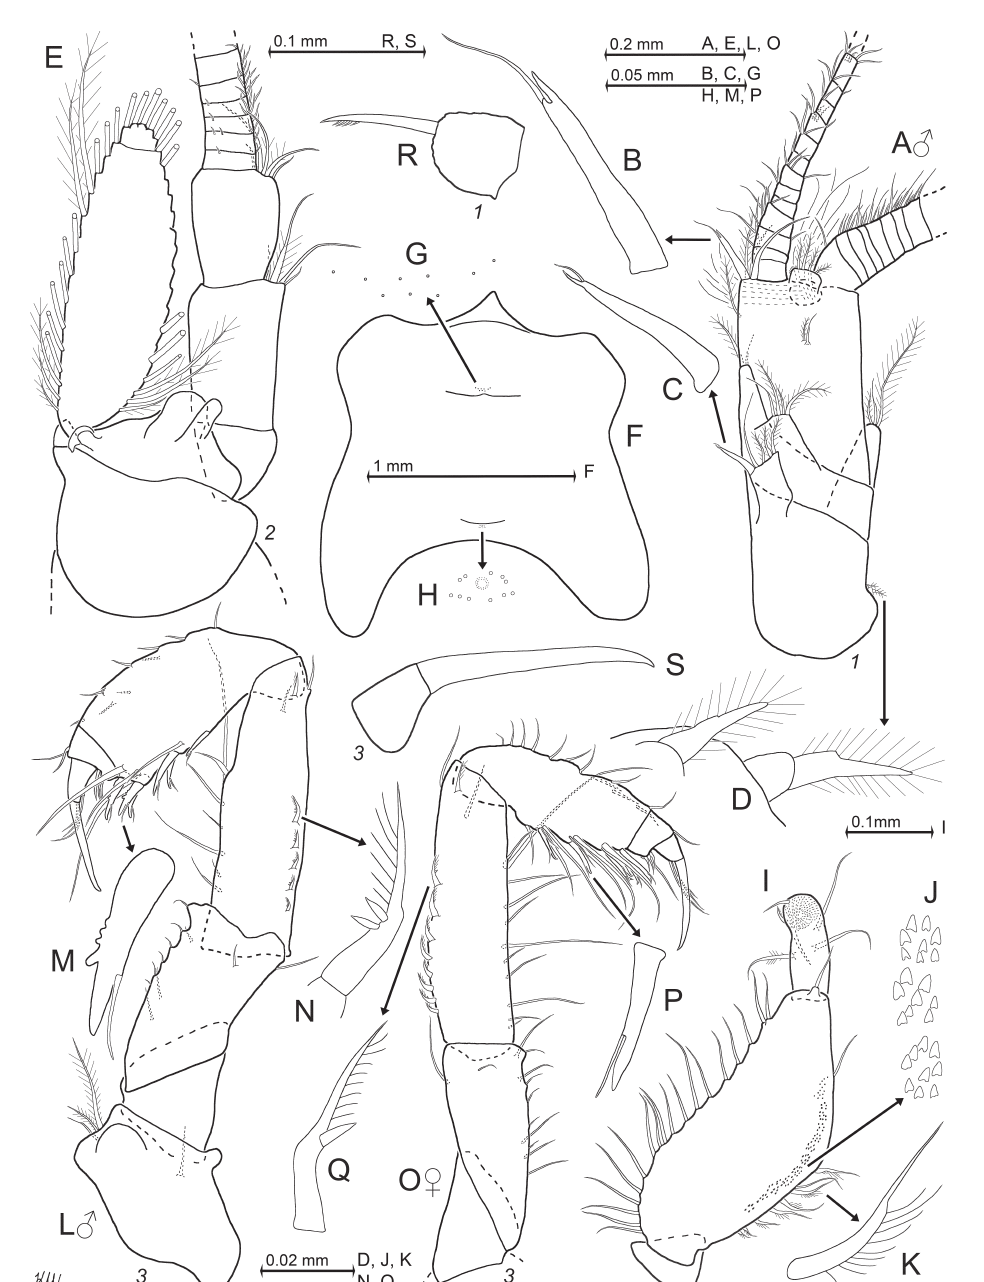
Fig. 2. Heteromysis smithsoniana sp. nov., paratypes, ♂♂ with body length 4.8 mm (A–D, I–K, R–S: NHMW 26971), 4.2 mm (E–H, L–N: NHMW 26972 ), and ♀ 4.2 mm (O–Q: NHMW 26970). A . Male antennula, dorsal. B–D . Details of antennula (A) showing modified spines (B–C) and setae (D). E . Antenna with antennal gland, dorsal. F . Carapace expanded on slide. G–H . Details of carapace (F) showing pore groups in front of cervical sulcus (G) and behind cardial sulcus (H). I . Palp of left mandible, rostral. J–K . Details of mandibular palp (I) showing three scale groups (J) and one modified seta (K) from inner margin of median segment; most setae of terminal segment are below drawing plane. L . Right male thoracic sympod and endopod 3, rostral. M–N . Details of male endopod 3 (L) showing modified spine (M) of carpus and modified seta (N) of merus. O . Left female thoracic endopod 3, rostral. P–Q . Details of female endopod 3 (O) showing modified spine (P) of carpus and modified seta (Q) of merus. R–S . Dactyli 1 and 3, with claw, setae